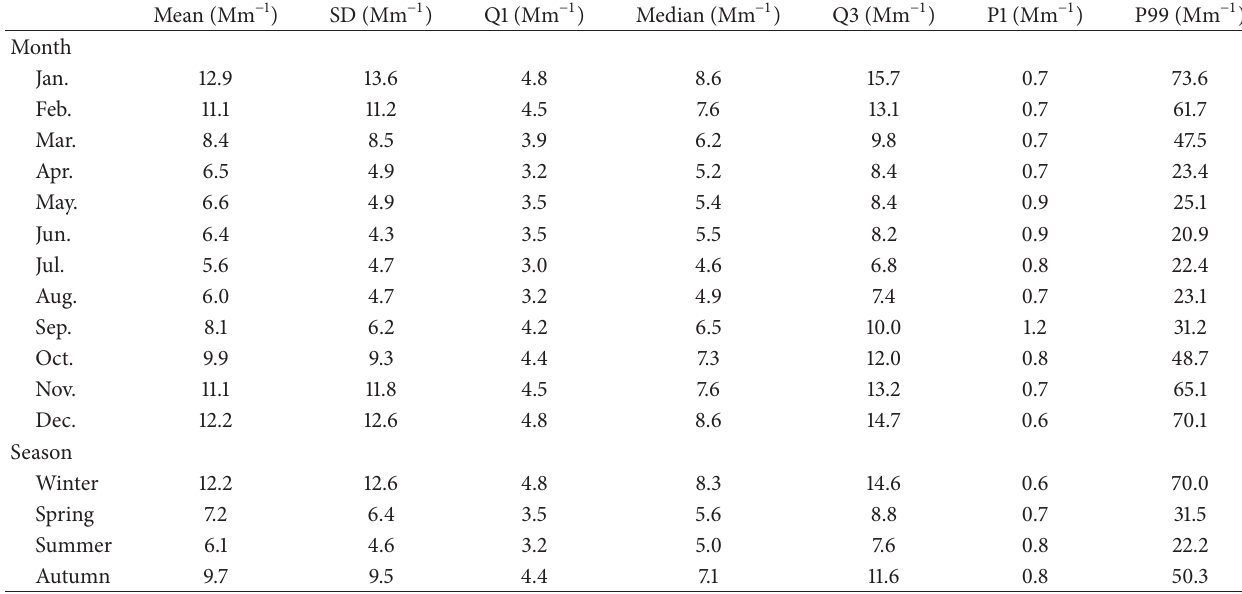
Table 1: Basic statistical properties of 𝜎 (670) organized for each month and season between 2007 and 2013. Q1 and Q3 indicate the quartiles; ap P1 and P99 indicate the 1st and 99th percentiles.